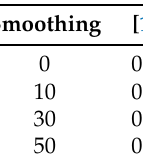
Figure 13. The results of the robustness comparison of Wang’s method [3] with the proposed method in terms of NC for the Bunny model against several attacks: A: noise 0.05%; B: noise 0.25%; C: noise 0.5% ; D: quantization of 9 bits; E: quantization of 8 bits; F: quantization of 7 bits; G: smoothing (0.1, 10 iterations); H: smoothing (0.1, 30 iterations); I: smoothing (0.1, 50 iterations). Table 17. Results of robustness comparison with Son et al.’s [11] method measured in terms of BER against